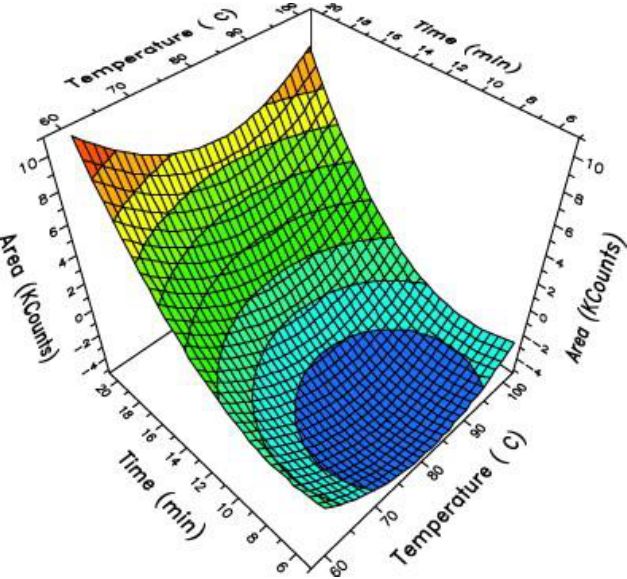
Figure 5. Surface contour plots from the optimization experimental set-up: effect of time and temperature of extraction over the total area counts. Reproduced from [57].